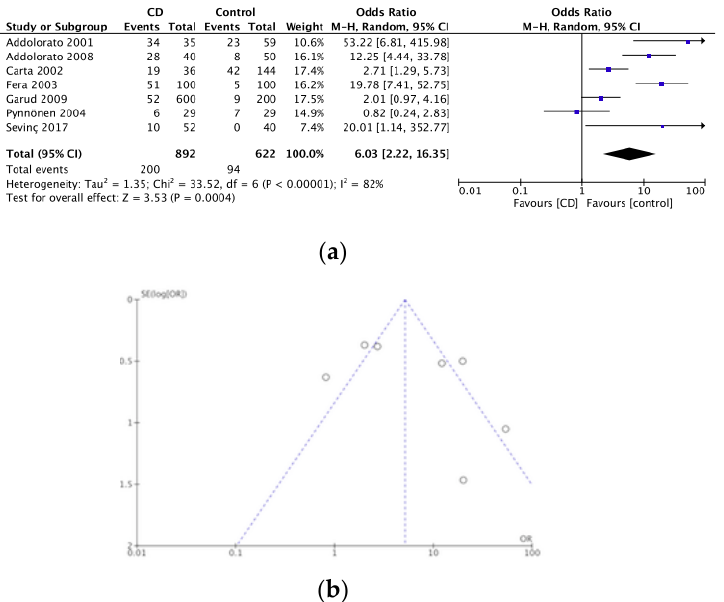
Figure 5. ( a ) Forest plot of pooled prevalence of anxiety in CD. ( b ) Funnel plot investigating distribution in anxiety studies.